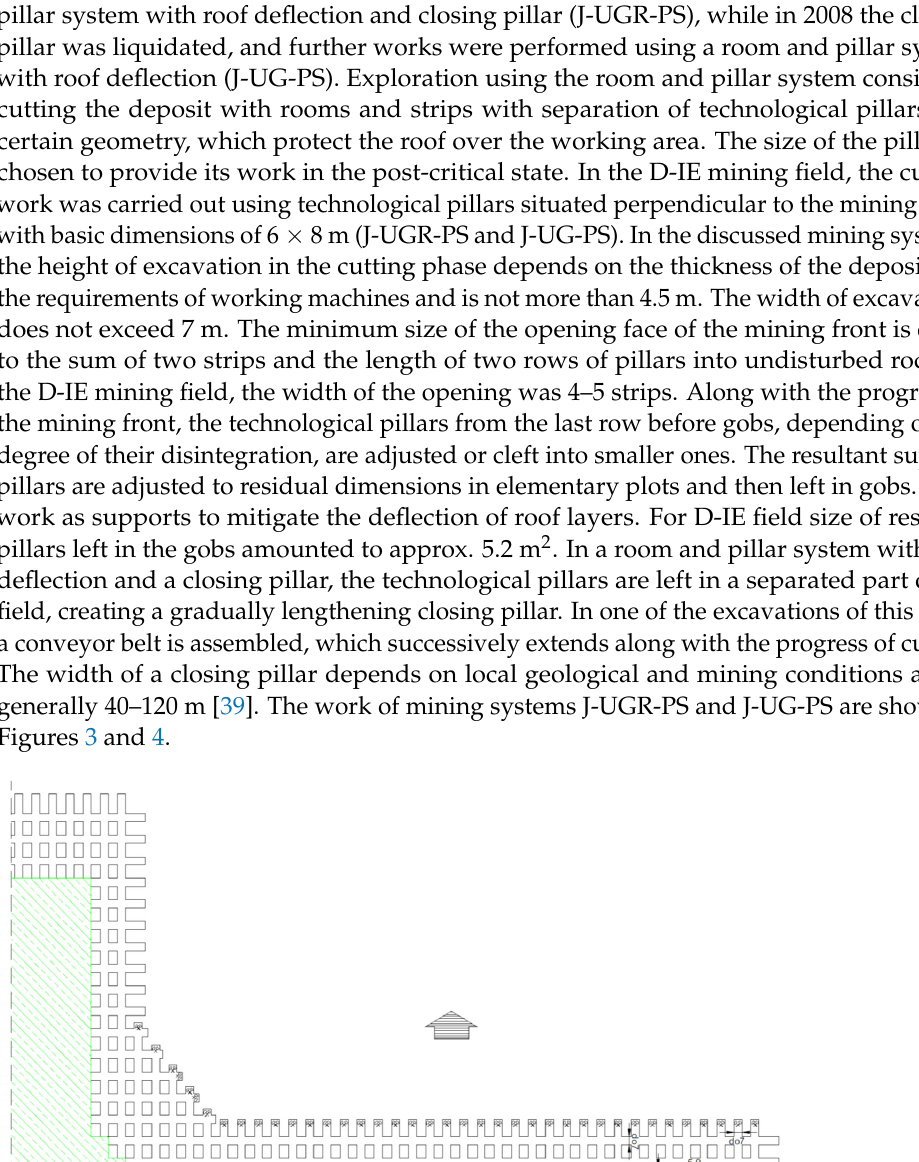
Figure 4. Room and pillar mining system with roof deflection J-UG-PS [42].